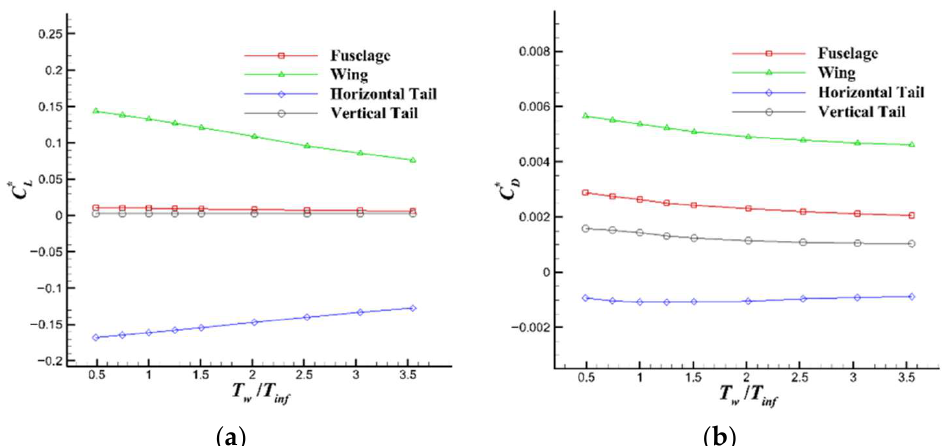
Figure 8. Effect of wall-temperature gradient on C L * and C D * of each component. ( a ) C L* – T w / T inf ; ( b ) C D* – T w / T inf .